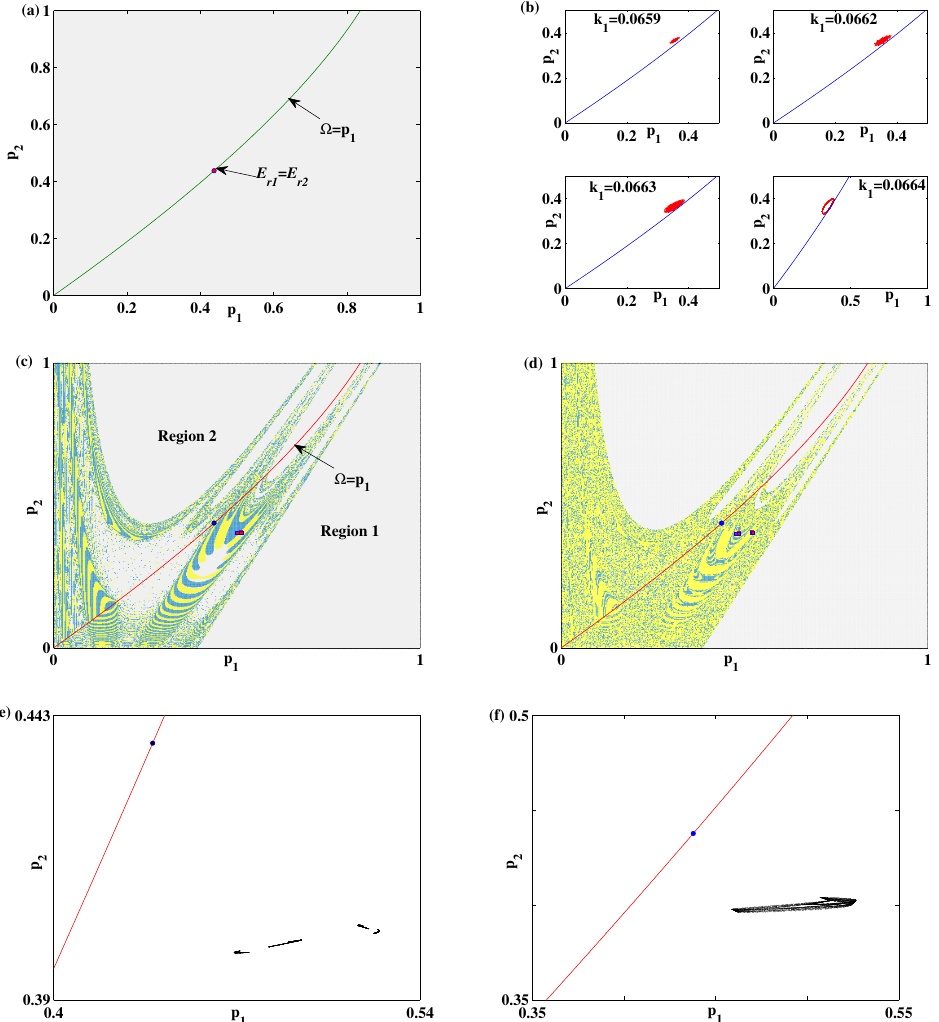
Figure 3. ( a ) The basin of attraction of the equilibrium points. ( b ) Spiral and closed invariant curves at different values of k 1 . ( c ) Basin of attraction of period-2 cycle at k 1 = 0.0827. ( d ) Basin of attraction of period-4 cycle at k 1 = 0.0834. ( e ) Phase plane for the four pieces chaotic areas at k 1 = 0.0836. ( f ) Phase plane for the one piece chaotic attractor at k 1 = 0.0845. Other parameters values are: c 1 = 0.41, c 2 = 0.45, θ = 0.9721801 and k 2 =